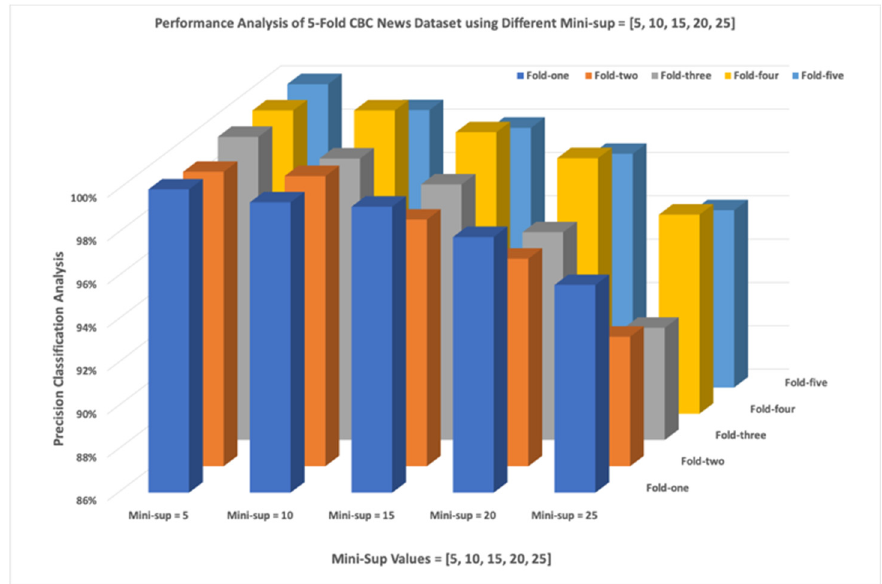
Figure 5. Shows the performance of NeoNet with different configurations of the min-sup parameter against CBC News Dataset using min-sup levels: [5, 10, 15, 20,